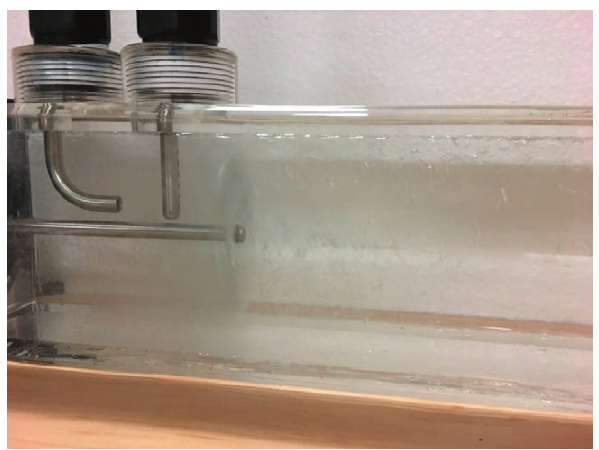
Figure 9. Cavitation occurring in flowing tap water at atmospheric pressure, i.e. in fully gassed water (at 2300 rpm).